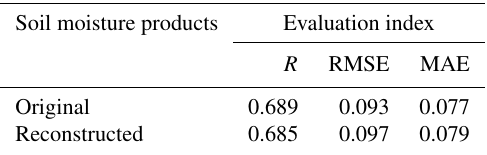
Table 1. Comparisons between original and reconstructed soil moisture